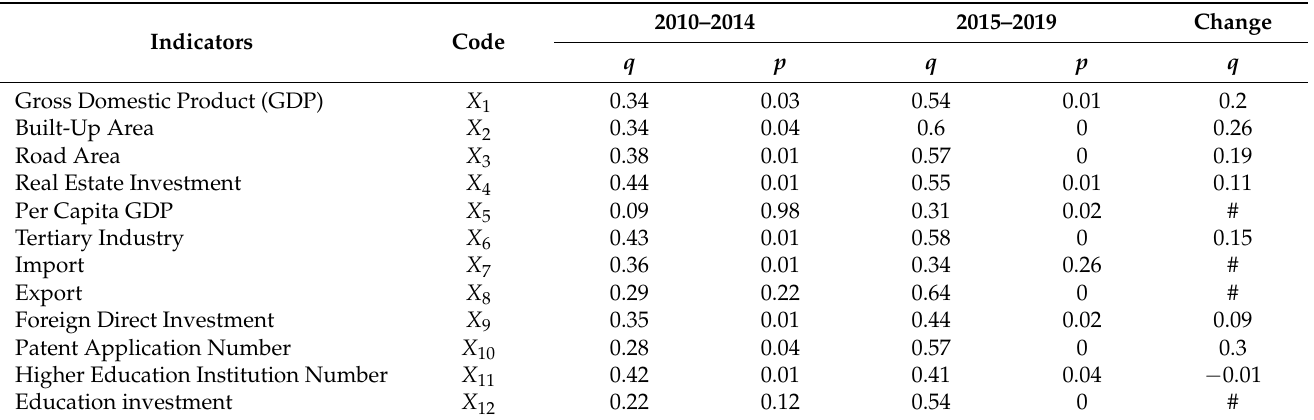
Table 5. Analysis of the evolution mode of independent variables in